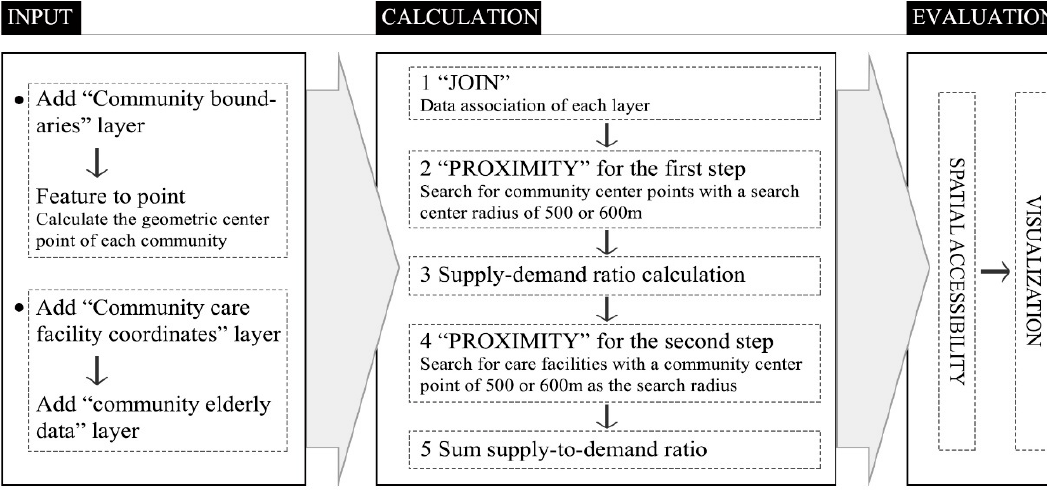
Figure 4. Implementation of the potential model in GIS.